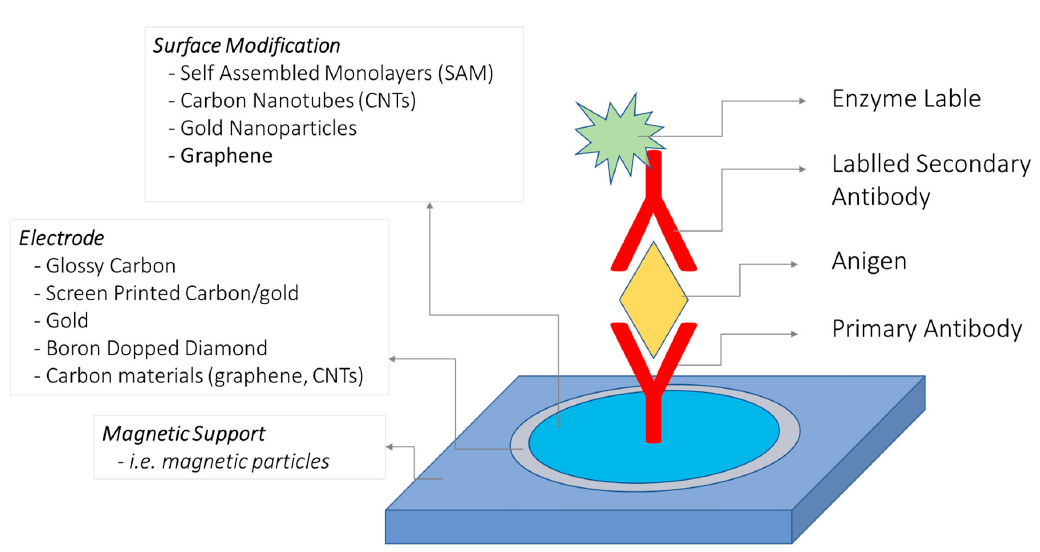
Figure 2 . Labeled/nonlabeled antibody based biosensor illustration. Figure 2. Labeled/nonlabeled antibody based biosensor